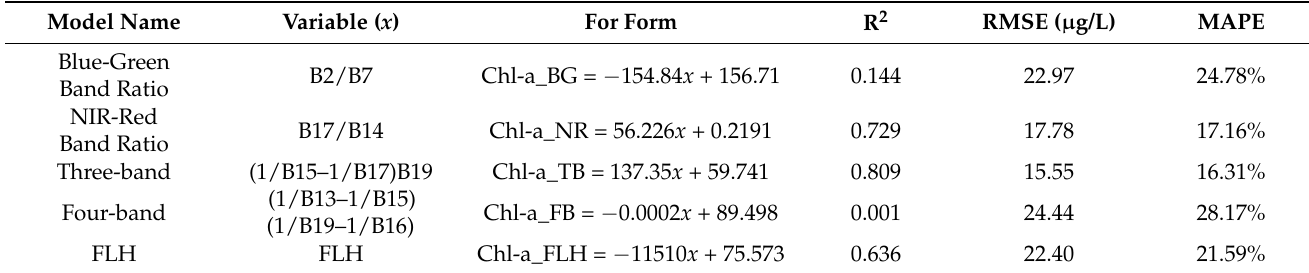
Table 3. Estimation model of Chl-a concentration based on simulated OHS imagery. R 2 , RMSE, and MAPE represent the determination coefficient, root-mean-square error, and mean absolute percentage error,